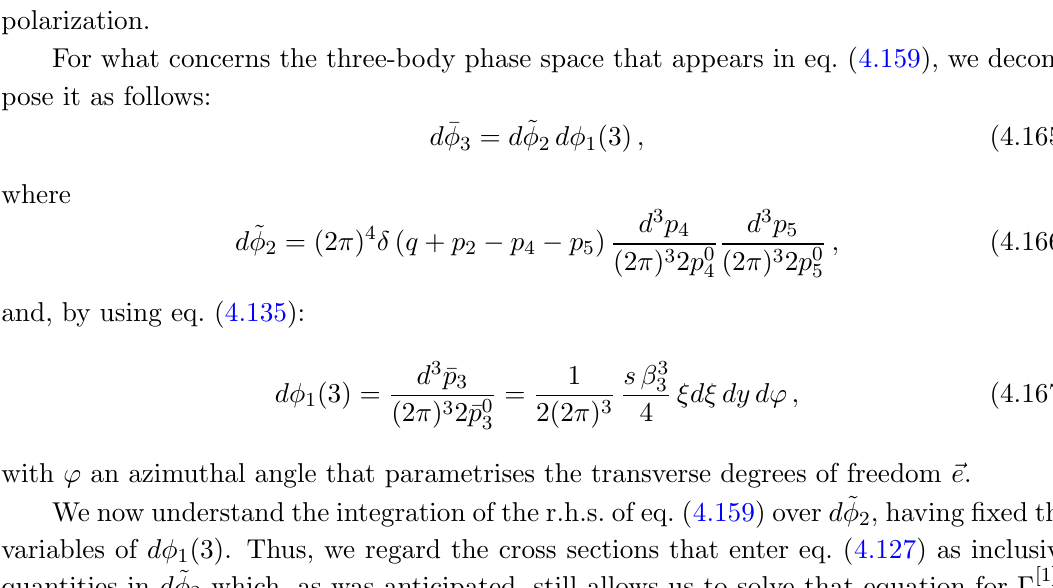
Figure 3 . Diagrams relevant to the process (cid:13)(cid:22) ! (cid:13)(cid:22) . These are also the sub-graphs obtained from diagrams #1 and #2 of (cid:12)gure 2 by stripping them of the e(cid:13)e current. muon polarization, and the factor (cid:0) g (cid:22)(cid:23) is the result of summing over the outgoing-photon